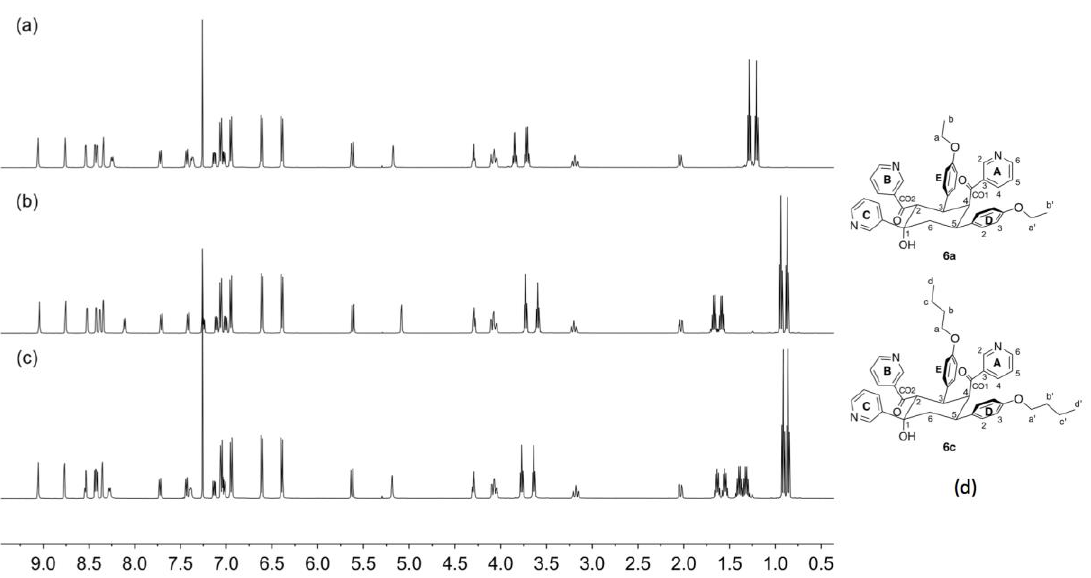
Figure 8. A comparison of the 1 H NMR (500 MHz, CDCl 3 , 298 K) spectra of the cyclic products ( a ) 6a , ( b ) 6b and ( c ) 6c . The singlet at δ 7.26 ppm in each spectrum is residual CHCl 3 . ( d ) The structures of 6a and 6c with atom labelling for NMR spectroscopic assignments (see Sections 4.5 and 4.6).